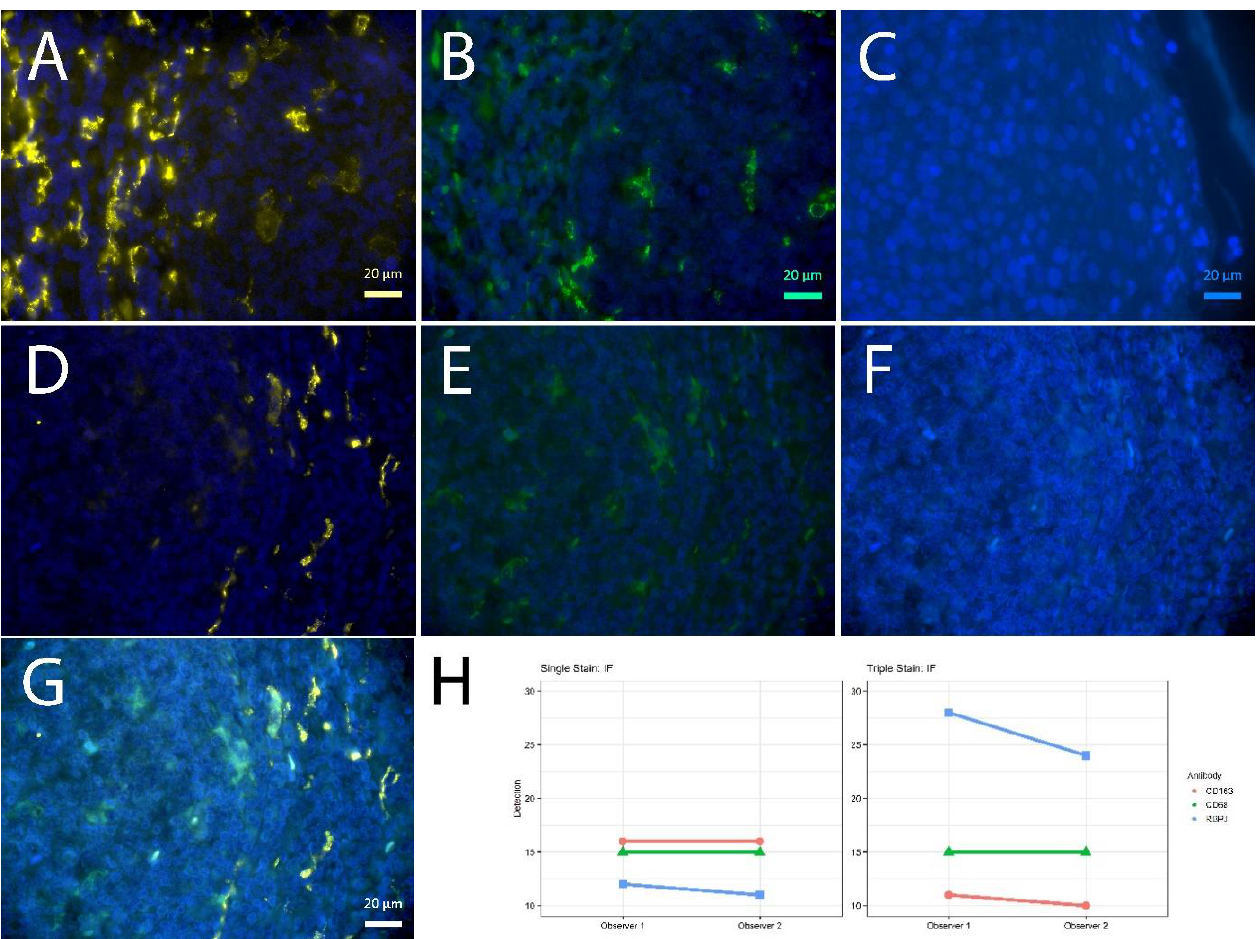
Figure 3. Single vs. triple stainings, immunofluorescence on human tonsil sections. ( A – C ) Single stainings: ( A ) CD163 555 gold, 2 min high pressure cooking citric buffer pH6 (HPC), ( B ) CD68 488 green, 20 min TRIS pH6.1, ( C ) RBPJ Aqua light blue, 2 min HPC. CD163 555 gold after 2 min HPC; CD68 488 green after pH6.1, RBPJ Aqua light blue after 2 min HPC; DAPI as counterstain, respectively. ( D – F ) Triple staining according to the FOLGAS protocol, separated by fluorescent channels with DAPI as nuclear background dye; antigen retrievals equivalent to the corresponding single staining: ( D ) CD163 555 gold, ( G ) CD68 488 green, ( J ) RBPJ Aqua light blue. ( G ) Triple staining, merged. Magnifications indicated by bar. ( H ) Sum of H-scores of the respective stainings under single and triple staining conditions, from two independent